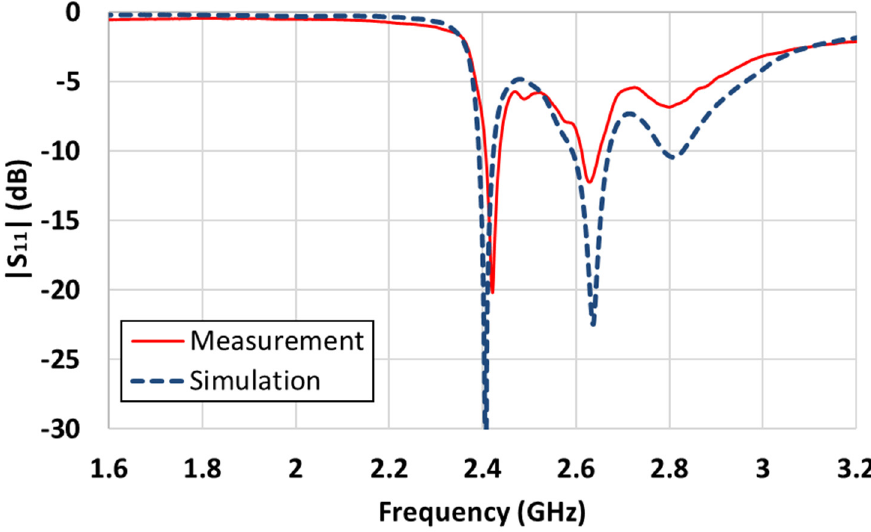
Figure 9. Simulated and measured |S 11 | of a Fabry-Perot cavity antenna.